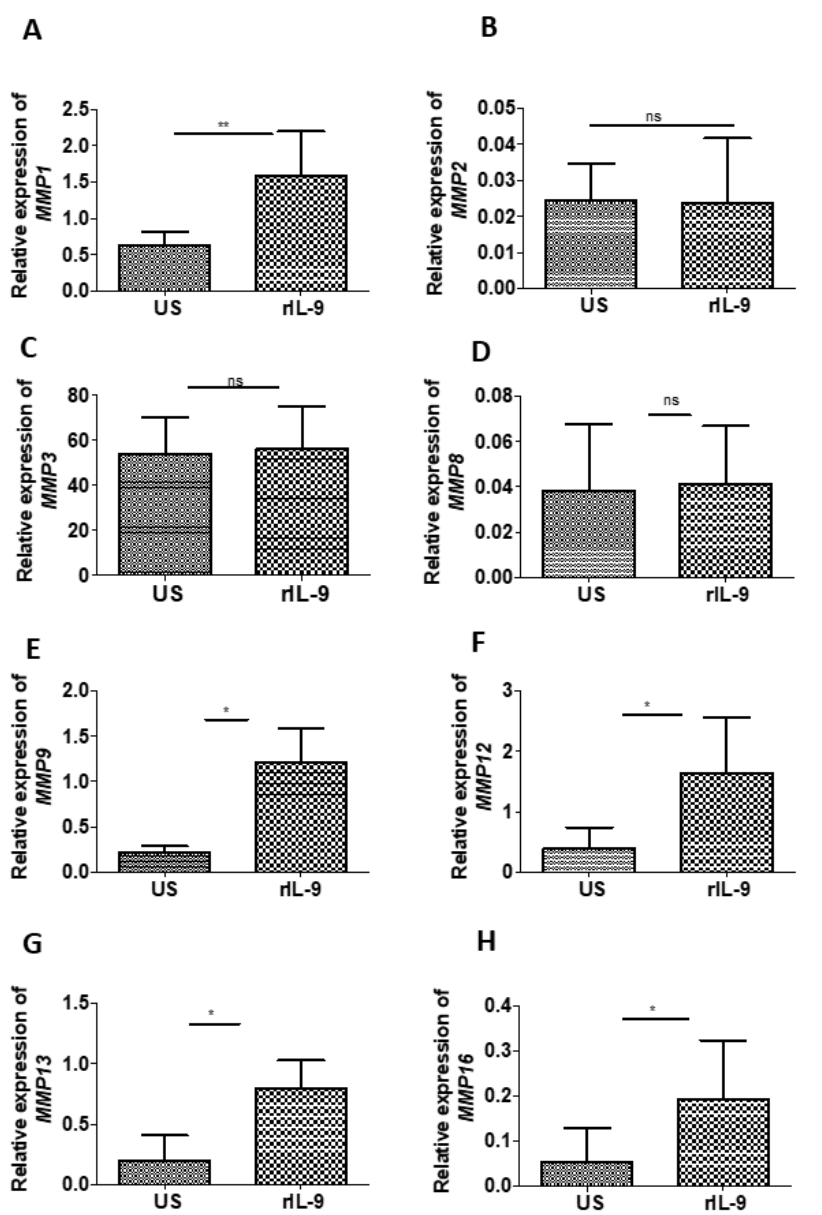
Figure 5. Effect of IL-9 on the expression of matrix metalloproteinases (MMPs). ( A – H ) Bone explant culture was stimulated with and without rIL-9 (100 ng/mL) for 5 days. Cells were then lysed and homogenized, followed by RNA extraction and cDNA preparation from an equal quantity of RNA. Glyceraldehyde phosphate dehydrogenease (GAPDH) was used as an internal control as the expression of GAPDH showed the least variation with stimulation. Quantitative real-time PCR (RT-PCR) was performed for MMP-1 ( A ), MMP-2 ( B ), MMP-3 ( C ), MMP-8 ( D ), MMP-9 ( E ), MMP-12 ( F ), MMP-13 ( G ), and MMP-16 ( H ). The graphs represent the relative expression of these genes (mean ± SD; n = 6). Statistical analysis was performed using paired Student’s t -test comparing treated cells to untreated cells (*: p ≤ 0.05; **: p ≤ 0.005; ns—non significant).